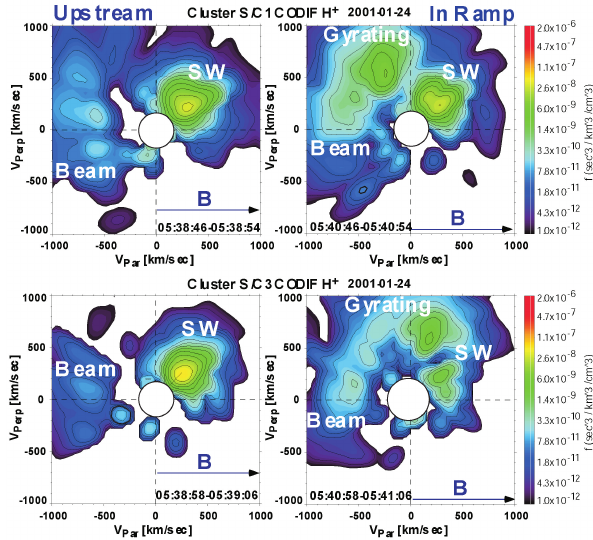
Fig. 2. Color-coded velocity distributions in B-V sw plane (B de- fines the direction of v para ) for SC1 and SC3 for the bow shock crossing at 24 January 2001. Also indicated are the magnetic field orientation, the solar wind, the gyrating ions and the ion